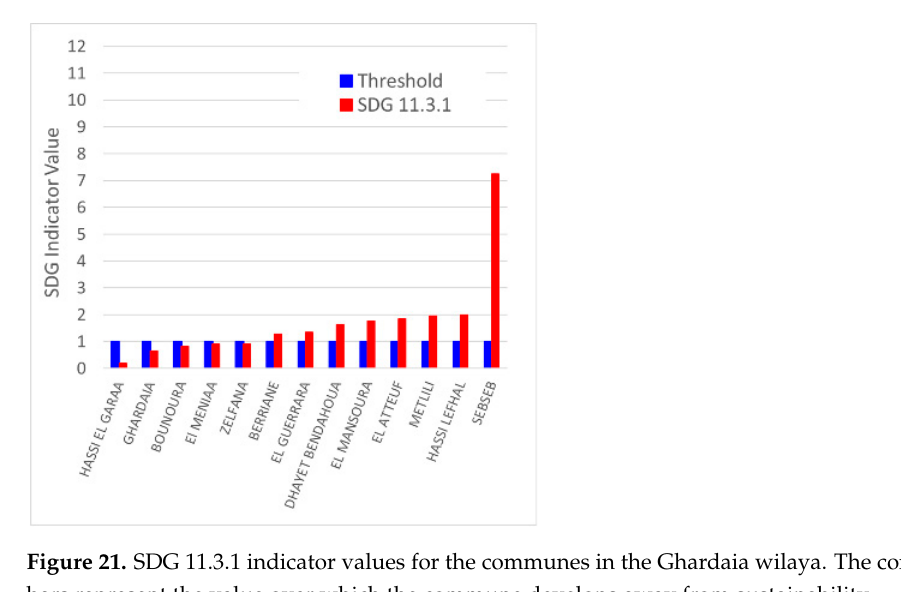
bars represent the value over which the commune develops away from